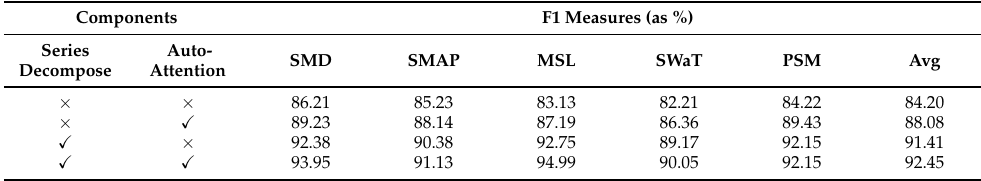
Table 3. Ablation study of series decompose and auto-attention modules.